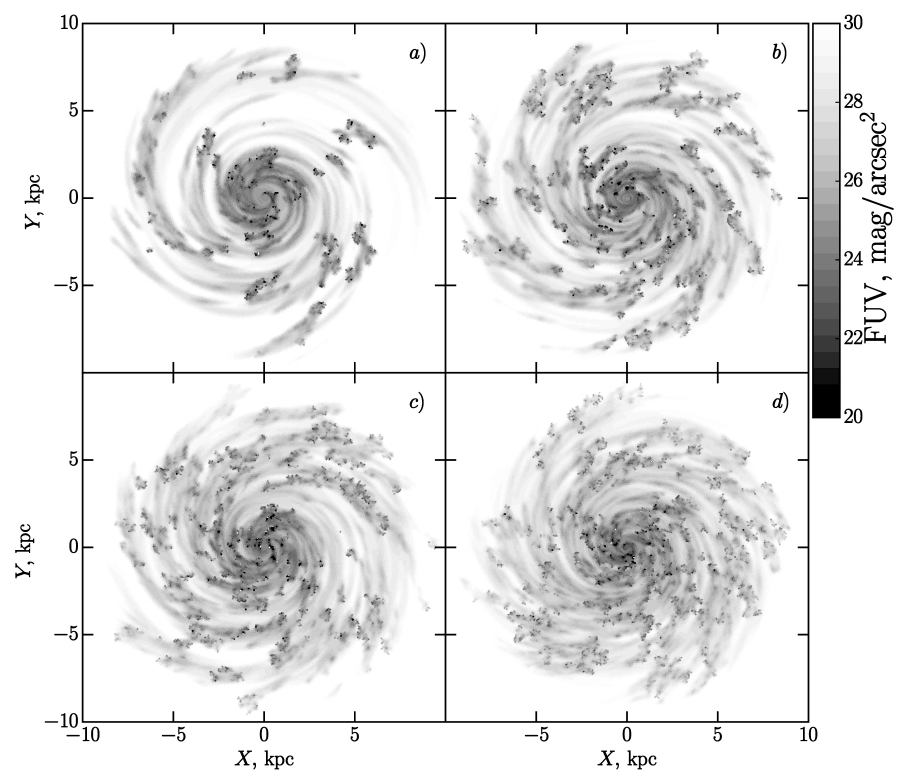
Fig. 5. The galaxy models from the “degeneracy valley” (Fig. 4) in the GALEX FUV passband: (a) P T = 0 . 30 , ϵ = 1%; (b) P T = 0 . 31 , ϵ = 0 . 6%; (c) P T = 0 . 32 , ϵ = 0 . 3%; (d) P T = 0 . 34 , ϵ = 0 . 2%. For all models, α = 2. The models possess very similar 1-D radial profiles, but they demonstrate different 2-D patterns of the young SF